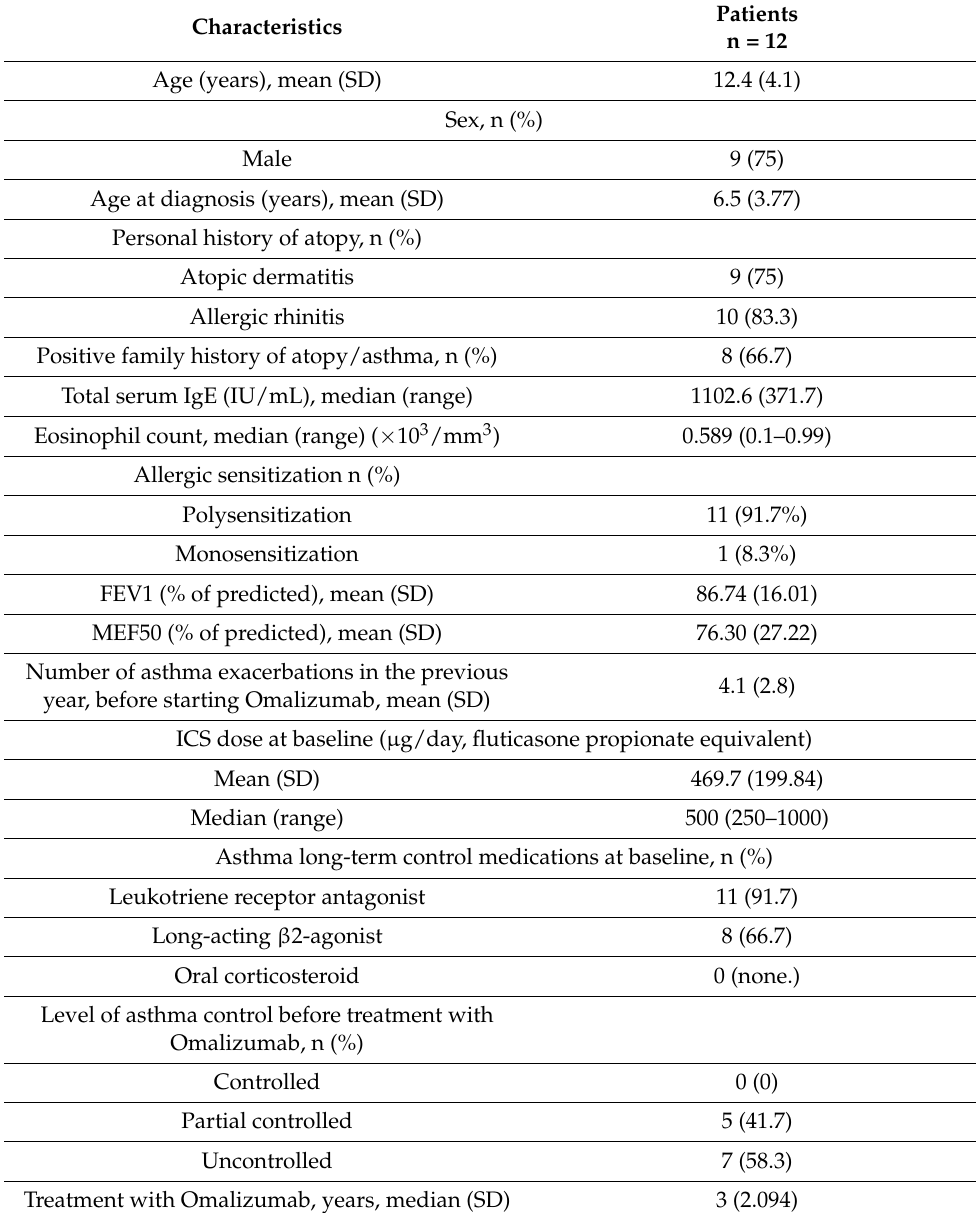
Table 1. Baseline demographic and clinical data of children and adolescents with asthma before treatment with Omalizumab (n =